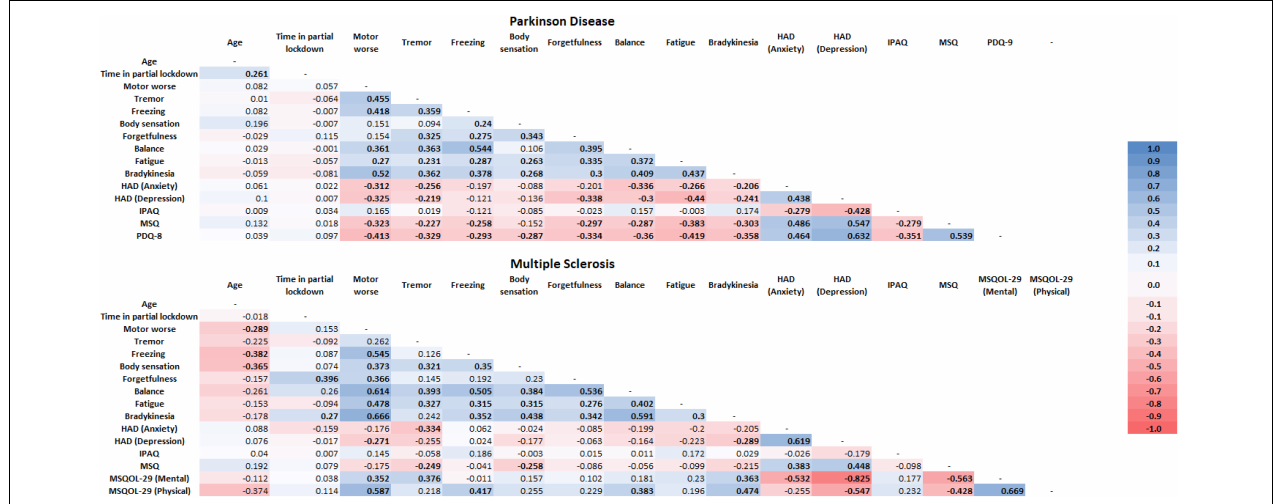
FIGURE 1 | Spearman rank correlation among the variables used and separately between the groups. In bold is presented the significance difference. HAD, hospital anxiety and depression; IPAQ, international physical activity questionnaire; MSQ, mini sleep questionnaire; PDQ-8, Parkinson’s disease questionnaire-8; MSQOL-29, multiple sclerosis quality of